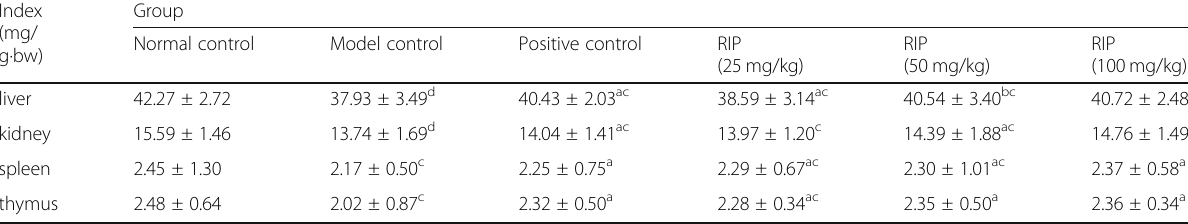
Table 3 Effects of different treatments on the liver, kidney, thymus and spleen indices in aging mice Index